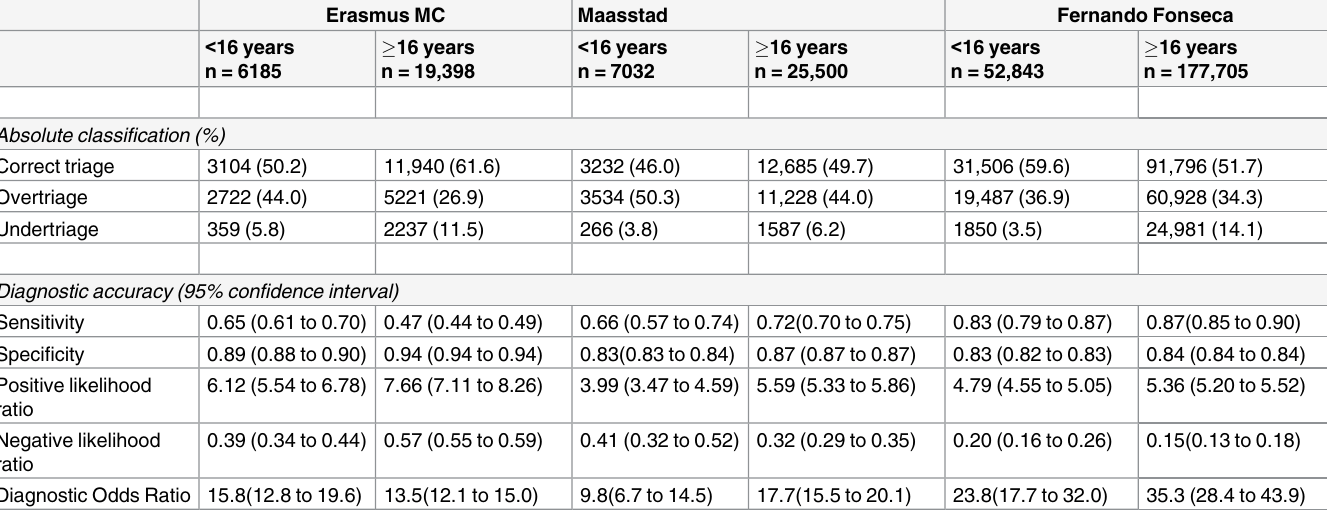
Table 4. Diagnostic performance of the MTS, as determined by the 3-category